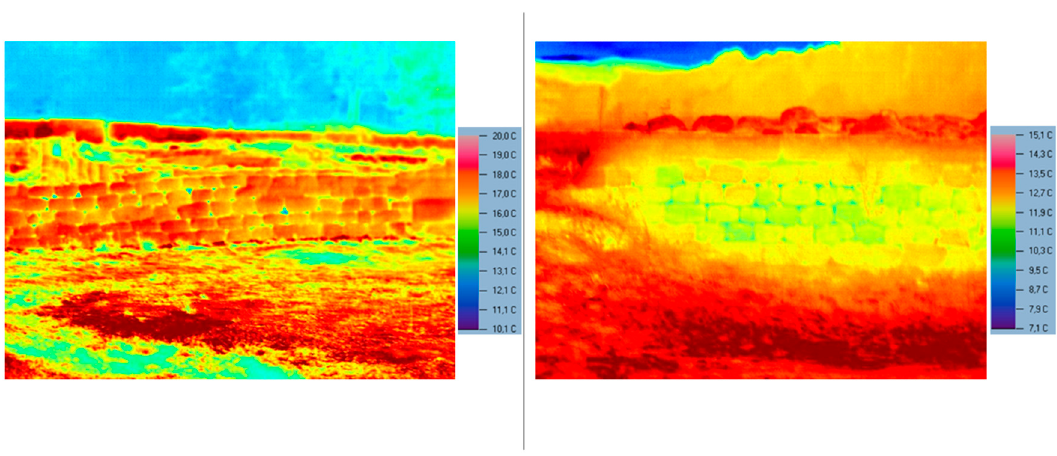
Figure 5. Examples of thermographic images acquired during the inspection of the excavated walls. ( Left ) completely original wall. ( Right ) partially reconstructed wall.